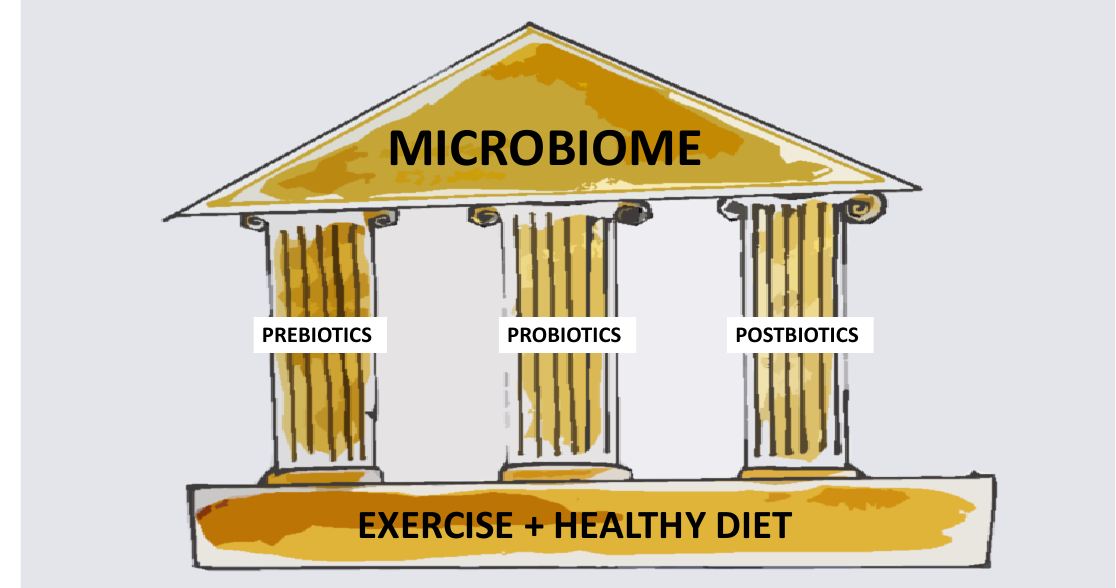
Figure 1. Optimal microbiome composition as a token of human wellbeing. Microbiome composition and structure is one of the factors determining proper human development and health. The roof that represents microbiome may be impermeable and reliable, only provided structures below are solid.